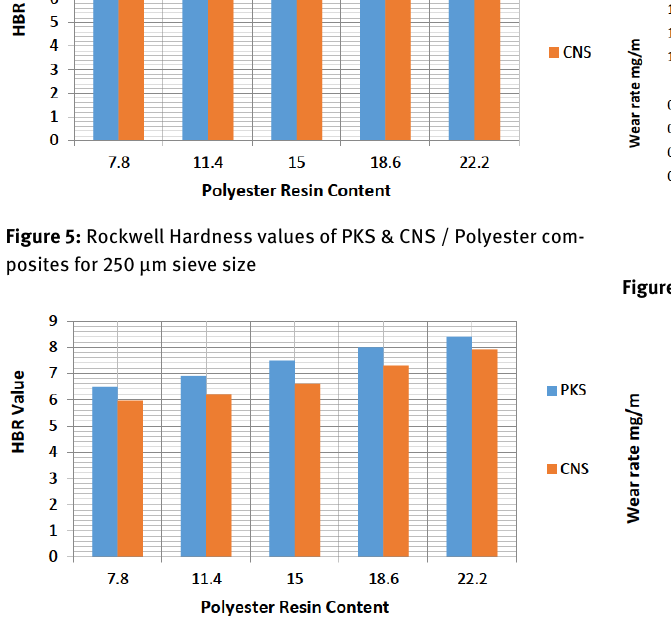
Figure 8: Wear rate of PKS /Polyester 250 µ m at 150 ∘